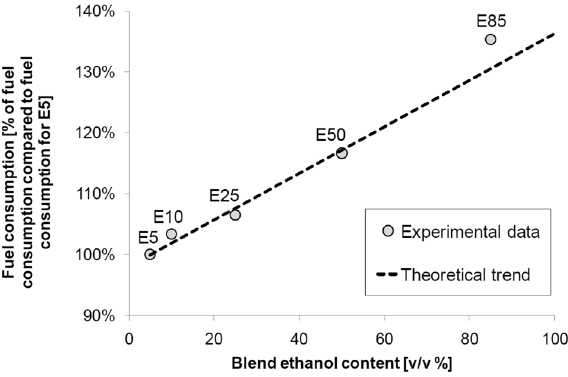
Fig. 5. Fuel consumption for an unmodified car running over the NEDC on various ethanol blends [27]